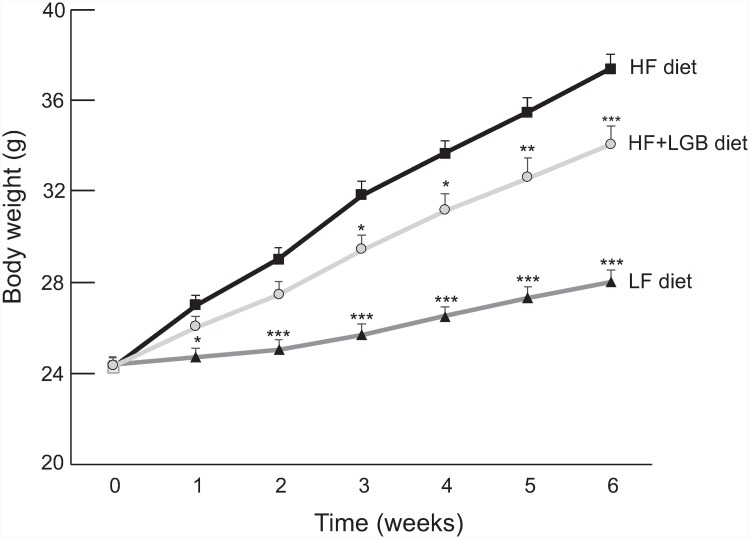
Body weight gain of the mice during the study.Animals received low-fat diet (LF diet, 10% of energy from fat, dark grey line), high-fat diet (HF diet, 46% of energy from fat, black line) or high-fat diet supplemented with lingonberry (HF + LGB diet, light grey line). Weight was measured once a week. The results are expressed as grams (g). Values represent mean + SEM, n = 10 mice per group. Repeated measures two-way ANOVA with Bonferroni post-test was used in the statistical analysis. Mean values significantly different from the high-fat group (HF diet) are marked with *p < 0.05, **p < 0.01 and ***p < 0.001.